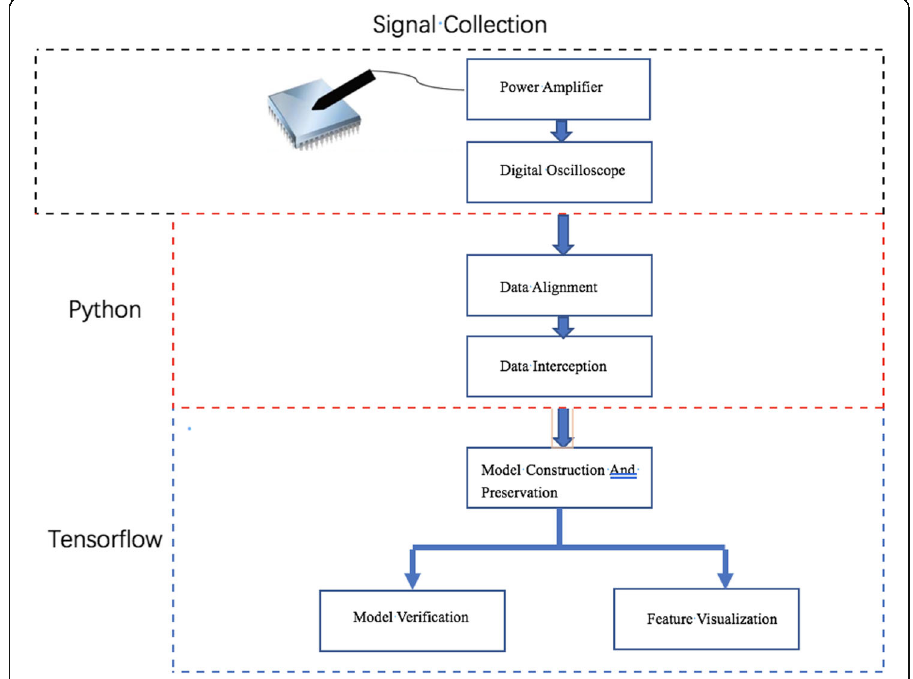
Fig. 1 Certification system process